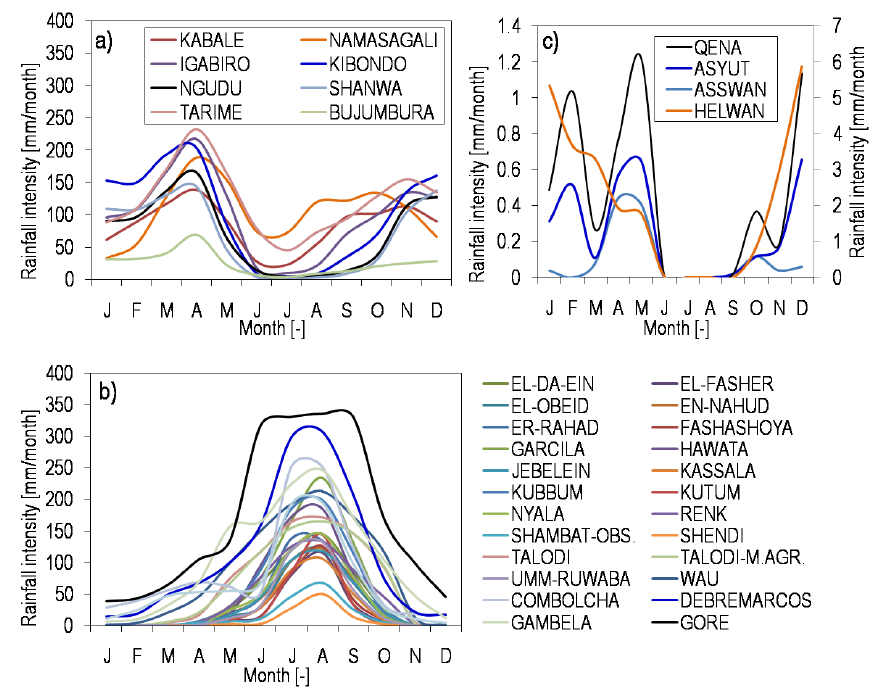
Figure 3. Long-term mean monthly rainfall pattern for group (a) A, (b) B, and (c) C.